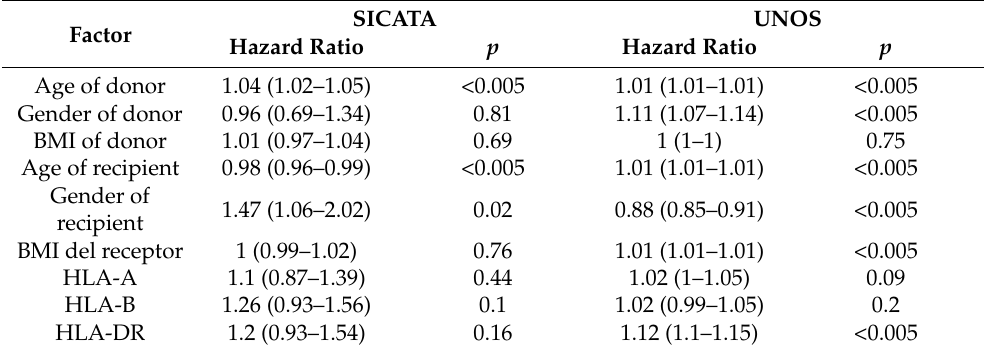
Table 4. Cox multivariate proportional hazards analysis of censored graft survival to failure for SICATA and UNOS at three years for all data.